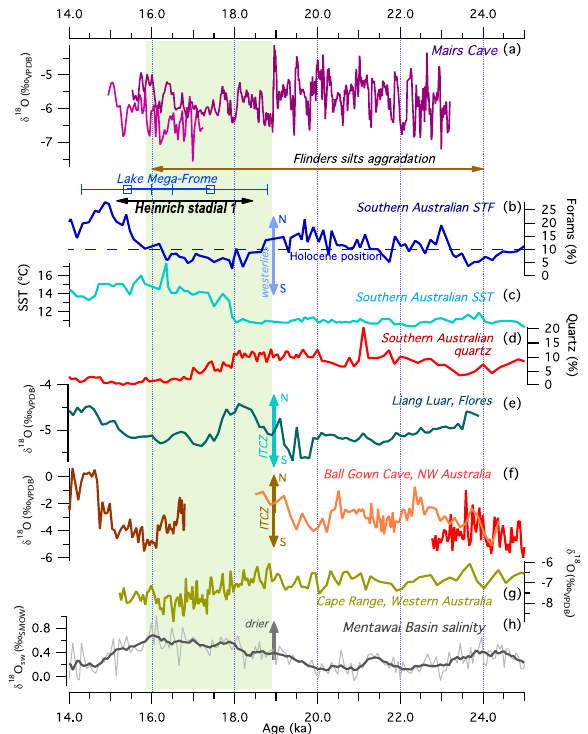
Figure 6. The Mairs Cave δ 18 O record (a) compared with the foraminifera record (b, c) and the quartz record (d) in marine core MD03-2611 from the Murray Canyons region, southern Australia (De Deckker et al., 2012). Speleothem records from Liang Luar, Flores (Ayliffe et al., 2013) (e) ; Ball Gown Cave, Western Australia (Denniston et al., 2013a) (f) ; and C126 Cave in Cape Range, also in Western Australia (Denniston et al., 2013b) (g) . Reconstructed salinity from marine care SO189-39KL from the northern Mentawai Basin, Indonesia (h)